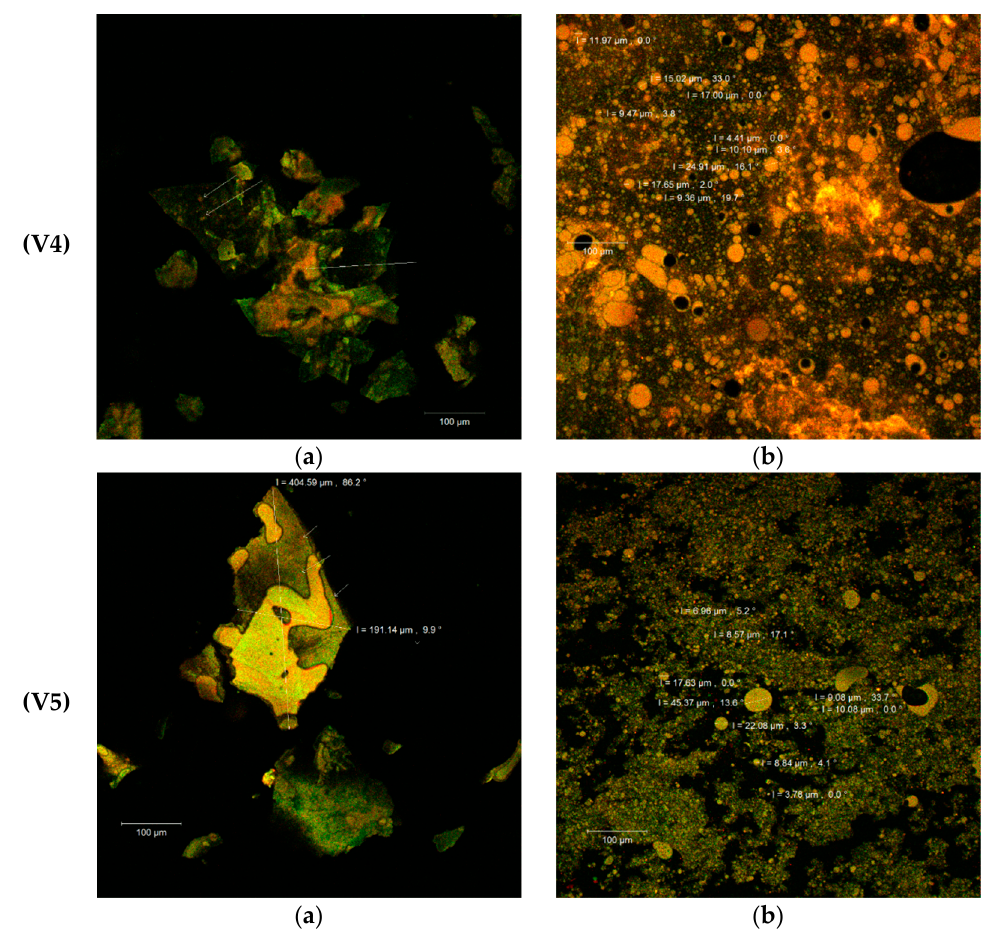
Figure 3. Microscopic details of the microencapsulated powders (V1–V5) in the native variants ( a ) and fluorescently labeled ( b ) by laser scanning with a Zeiss confocal system (LSM 710).